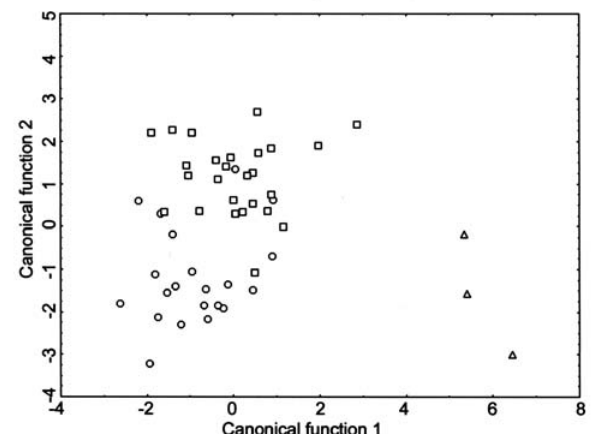
Fig. 6 . Results of the canonical variable analyses comparing Pseudotocinclus juquiae (circles), P. tietensis (squares), and P. parahybae